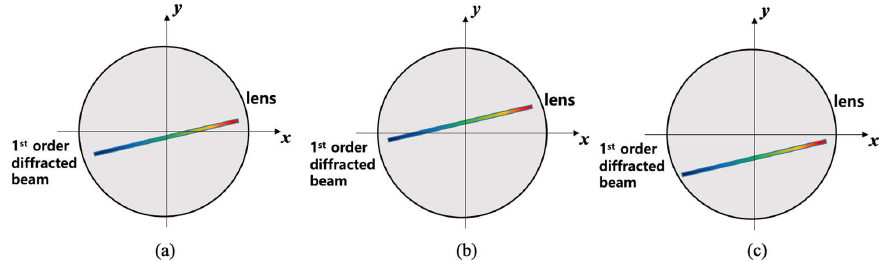
Figure 5. First-order diffracted beam incident on the lens surface according to the alignment state of the diffraction grating; ( a ) Case 1: initial state of the alignment, ( b ) Case 2: rotate −0.018° around the x -axis in Case 1, and ( c ) rotate 0.0045° around the x -axis in Case 1.